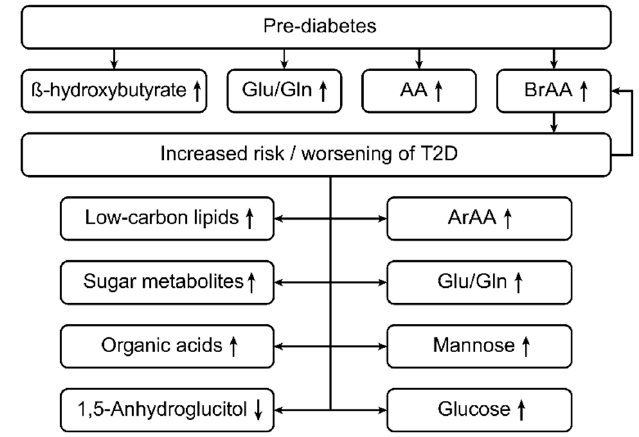
Figure 3. This figure shows the metabolic changes in type 2 diabetes (T2D) patients. In type 2 diabetes, the levels of branched-chain amino acids (BRAAs), aromatic amino acids (ArAAs) and the glutamine/glutamate ratio (Glu/Gln) are increased [1,3,23,25]. Prior to the onset of diabetes mellitus (DM) type 2, the levels of BRAAs, ArAAs, and ß-hydroxybutyrate and the Glu/Gln ratio are increased, even in prediabetic patients [25]. In type 2 diabetes, the levels of low-carbon lipids, sugar metabolites, organic acids, mannose and glucose are increased, but the levels of 1,5-anhydroglucitol are decreased